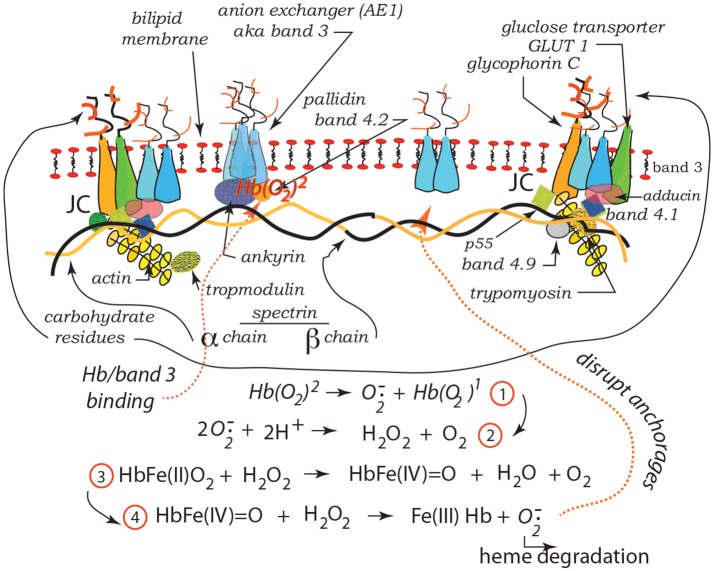
Hb binding to band 3. ROS reactions leading with Hb to degraded heme and binding and disruption of band 3 skeleton anchorage (Low et al., 1985; Nagababu and Rifkind, 2000; Cao et al., 2009; Rifkind and Nagababu, 2013; Mohanty et al., 2014). The JC complex is described in section 2 in detail.